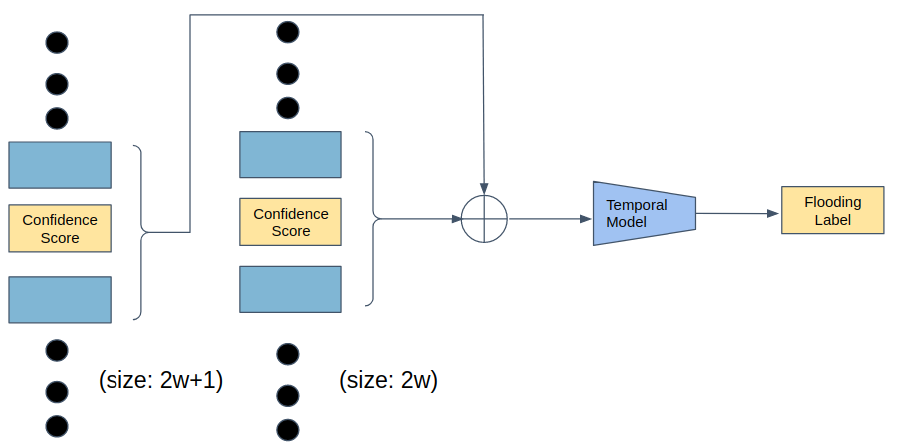
Figure 4. The temporal model stage of the flooding detection. We define a window size w . Then for an image at time t , we concatenate the confidence scores of flooding bounding box of images from time t − w to t + w , and the mean squared error (MSE) of the pixel values between two consecutive drain tube images. We input them into the temporal model to predict the existence of flooding at time t